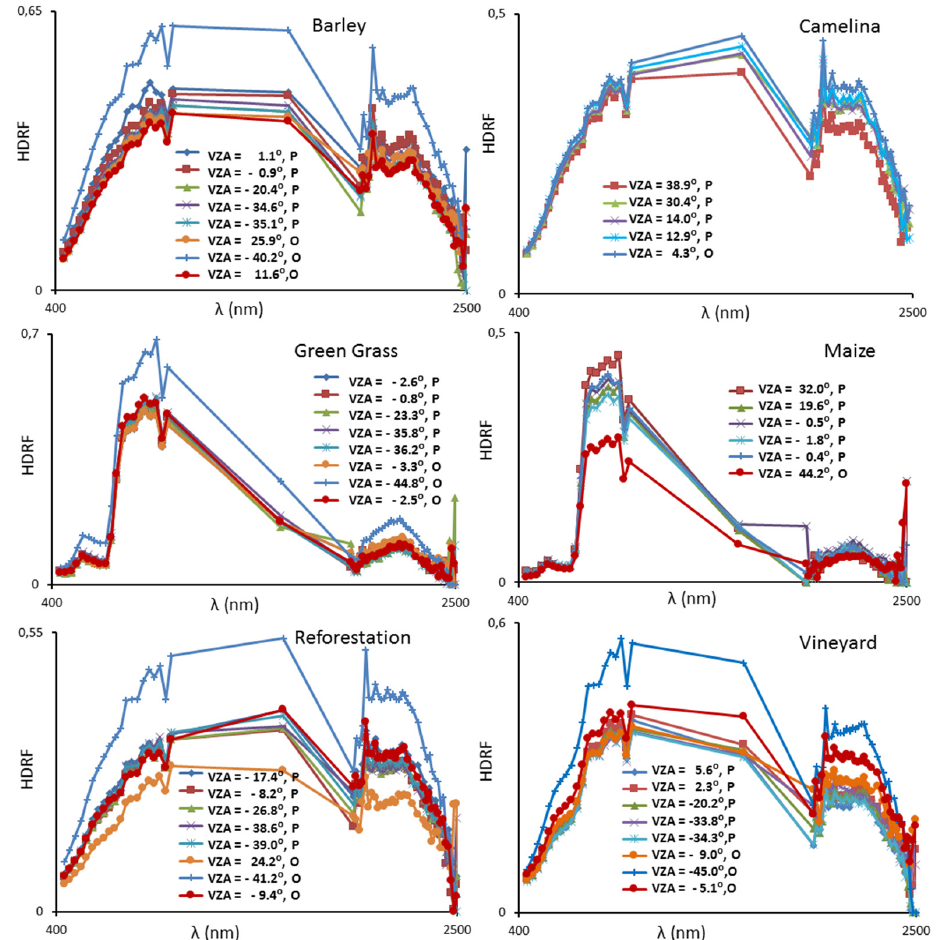
Figure 6. Airborne HDRF as a function of wavelength at sites with the following land cover types: barley, camelina, green grass, maize, reforestation, and vineyard on 25 July 2012. P = flights parallel to the solar principal plane; O = flights orthogonal to the solar principal plane. The View Zenith Angle of the site for each flight is also indicated. Flight identifications: blue solid diamond (8:51 UTC), red solid square (9:02 UTC), green solid triangle (9:10 UTC), indigo × sign (9:19 UTC), blue asterisk (9:28 UTC), orange solid circle (8:43 UTC), blue plus sign (9:38 UTC), and red solid circle (9:46 UTC).